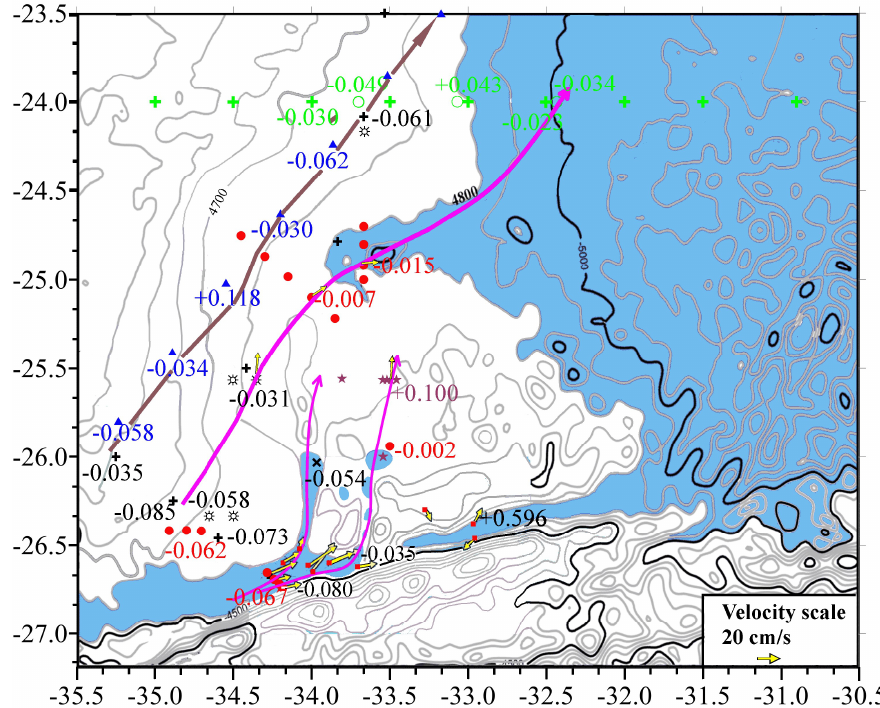
Water 2022 , 14 , x FOR PEER REVIEW 5 of 12